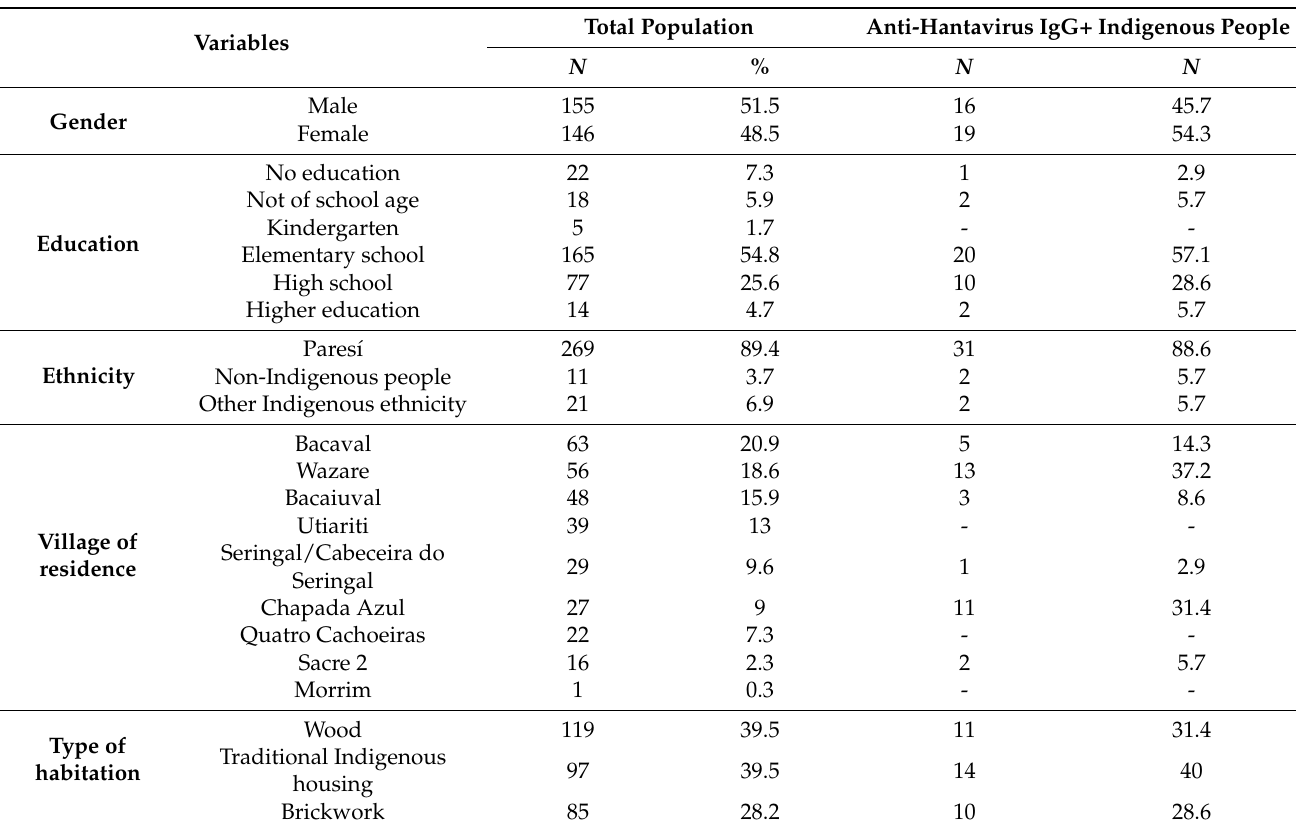
Table 1. Sociodemographic characteristics of the total population of the Haliti–Pares í Indigenous people ( N = 301), Utiariti Indigenous land, Campo Novo do Parecis,